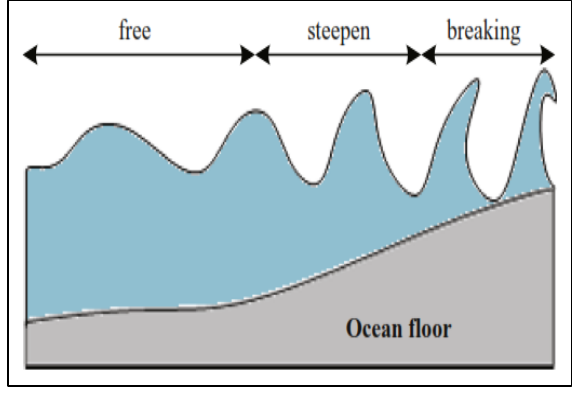
Figure 3. Changes in the wave shape relative to its propagation towards the